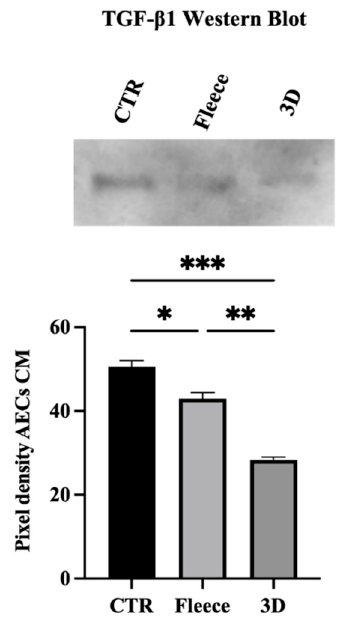
Figure 9. Western Blot confirms TGF- β 1 protein CM expression among the different groups as revealed thought the human inflammation antibody array analysis. *, **, and *** are statistically